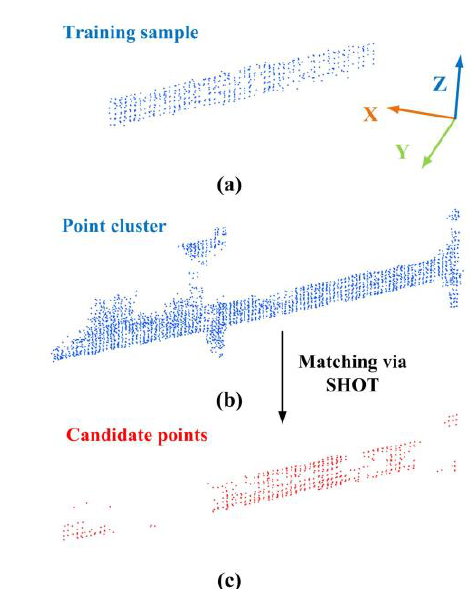
Figure 12. Matching of candidate points for toeboard modelling, a) the training sample, b) the point cluster used, c) the matched candidate